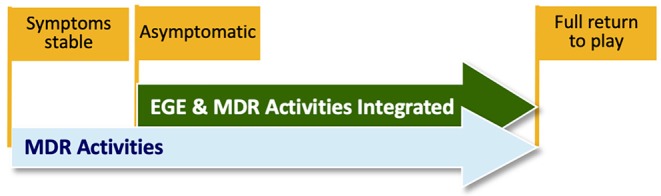
Example illustration of Multidimensional Rehabilitation (MDR) activities being integrated to the Enhanced Graded Exertion (EGE) progression. This figure illustrates the overlap in activities. MDR activity may be integrated as soon as the participant is asymptomatic.